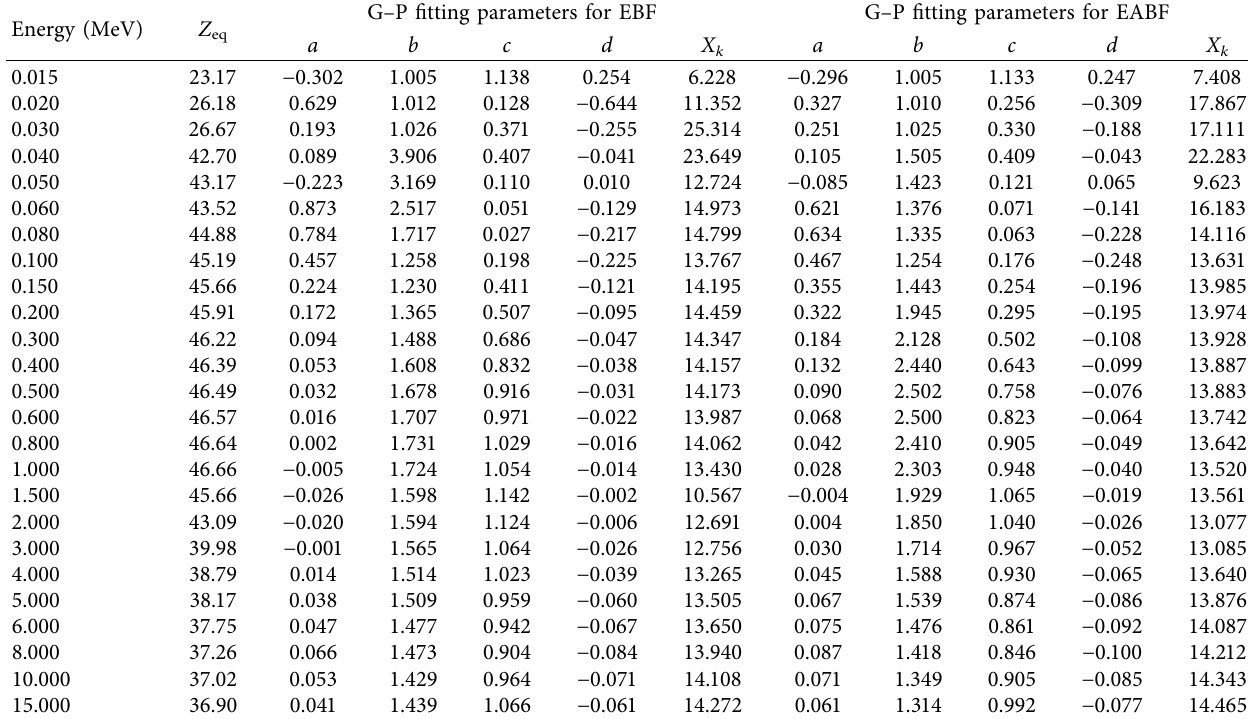
Table 4: (EBF and EABF) G–P fitting coefficients ( b , c , a , X